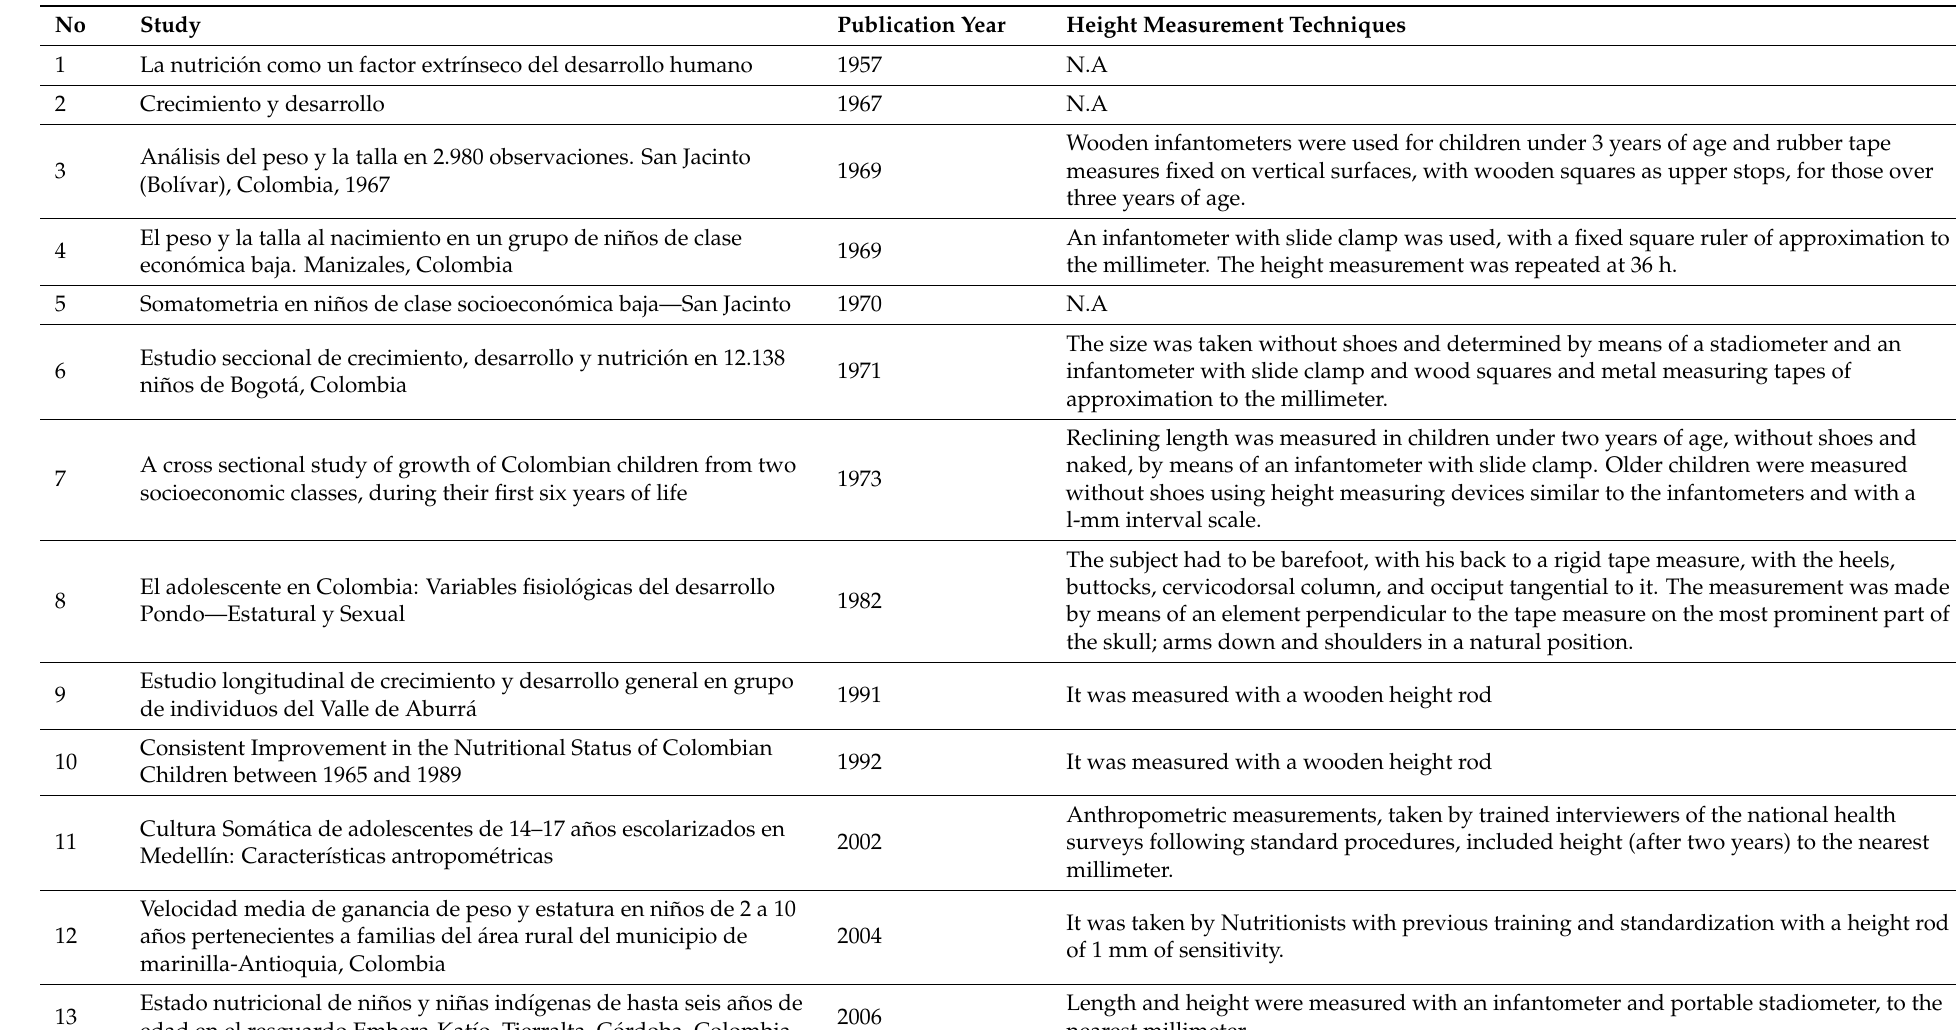
Table A2. Height measurement